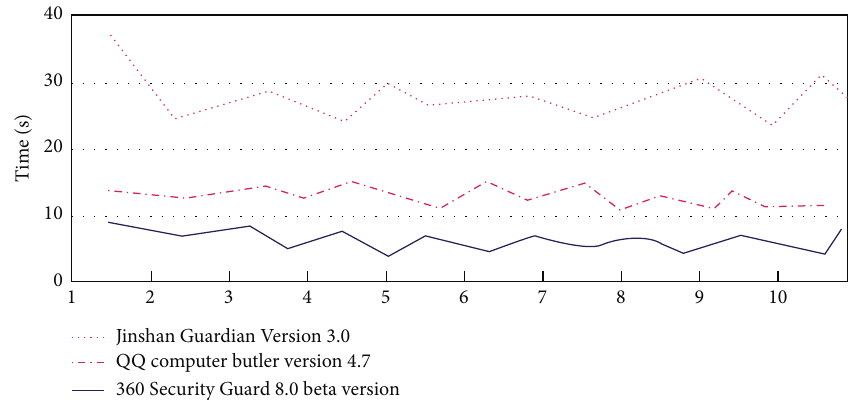
Figure 7: Computer multimedia security protection system performance test